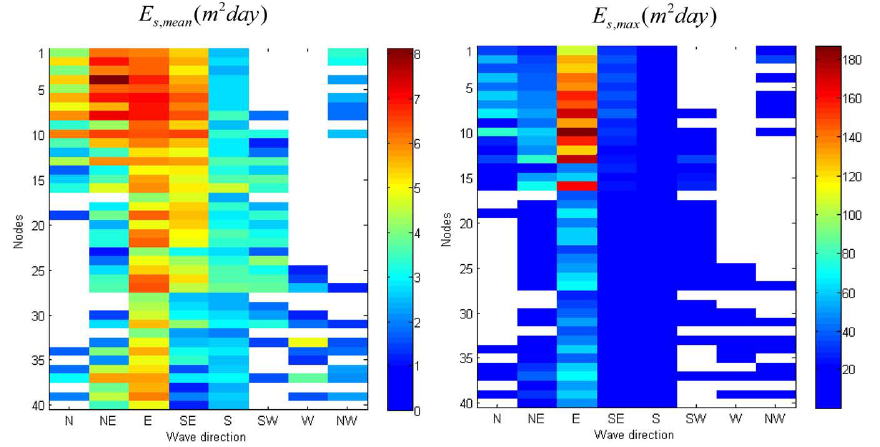
Fig. 5. Mean and maximum E s for each direction and each node along the Catalan coast.